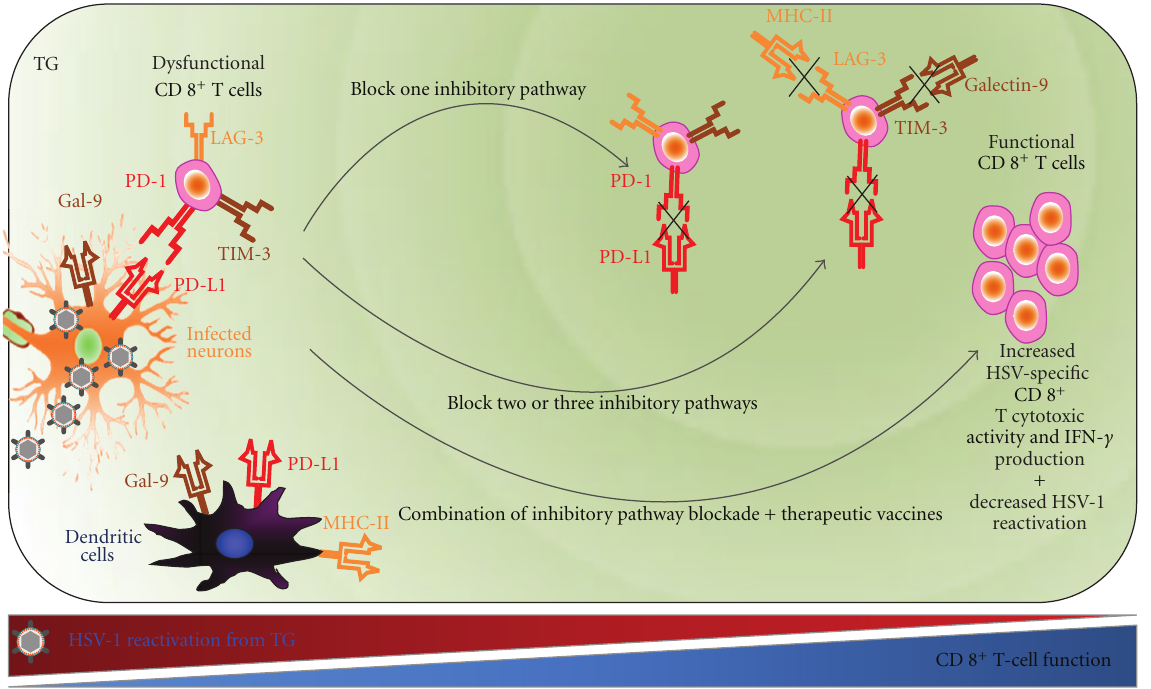
Figure 4: Blockade of T-cell inhibitory pathways to boost immunity to herpes simplex virus infections. Multiple inhibitory pathways may be activated in the exhausted CD8+ T cells in the HSV-1 latently infected TG, including PD-1, TIM-3, and LAG-3. Blockade of one T-cell inhibitory pathway may partially restore HSV-specific CD8+ T-cell e ff ector functions. Blocking antibodies may be directed against the PD-1, TIM-3 and LAG-3 T-cell inhibitory receptors on CD8+ T cells or possibly their ligands (PD-L1 galectin-9 and MHC-II, resp.) on infected neurons or on DC. Full restoration of CD8+ T-cell function may require blockade of two or more inhibitory pathways or a combination of pathway blockade and vaccination. Sustained restoration of DC maturation may be also crucial for functional CD8+ T-cell function and clinical cure. HSV-1 LAT gene appears-interfering with both CD8+ T-cell function and with DC maturation. How CD8+ T cells are dysfunctional and DC are silenced, and the pathways to rescue this silencing, is still